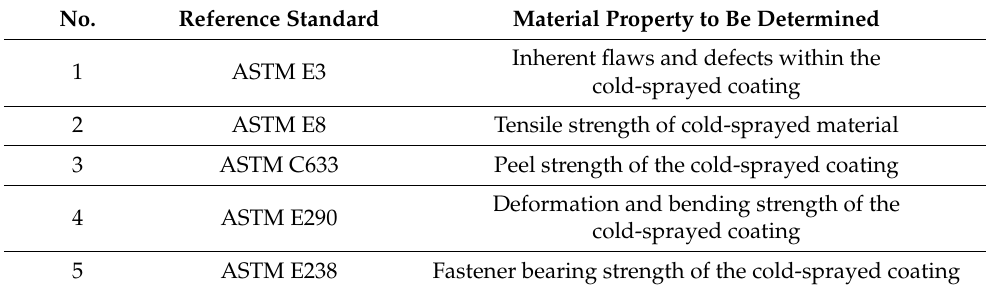
Table 1. Reference Standards for Material